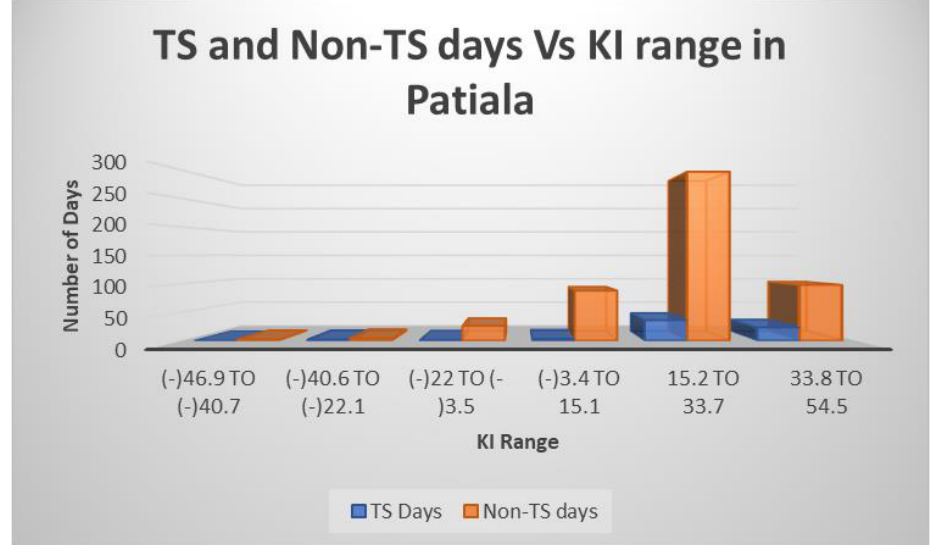
Figure 6. The distribution of thunderstorm (TS) and non-thunderstorm days in the given KI range over Patiala.